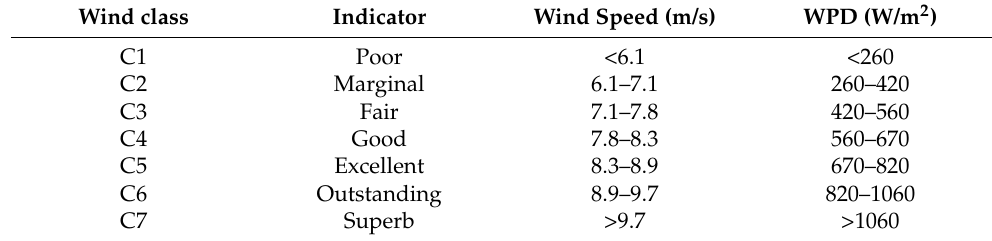
Table 2. U 100—wind classification according to Oh, et al. [19].